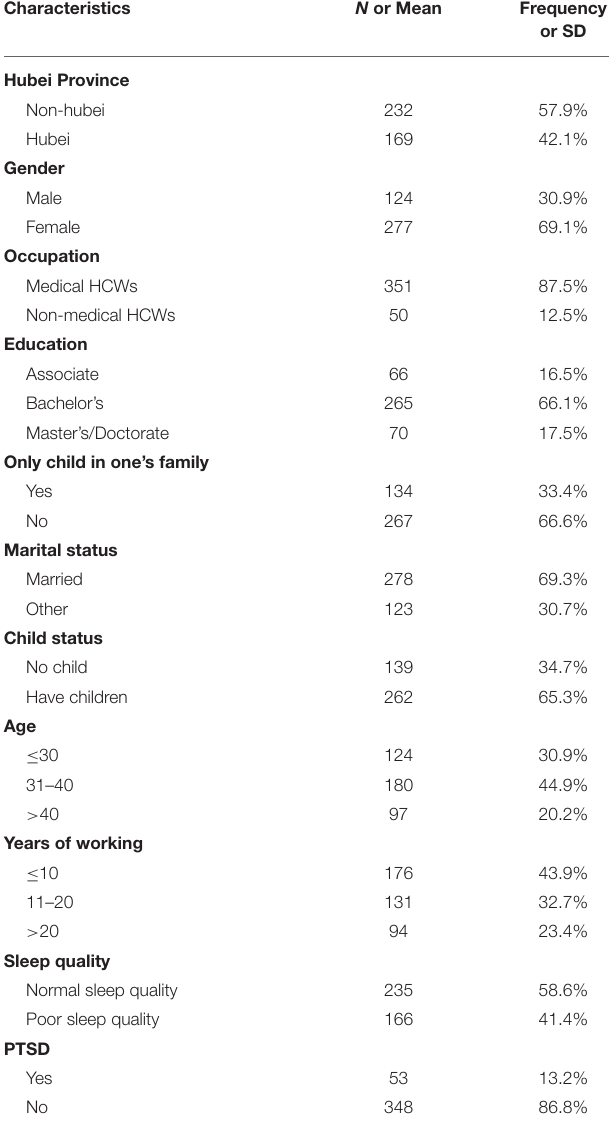
TABLE 1 | Sociodemographic variables of